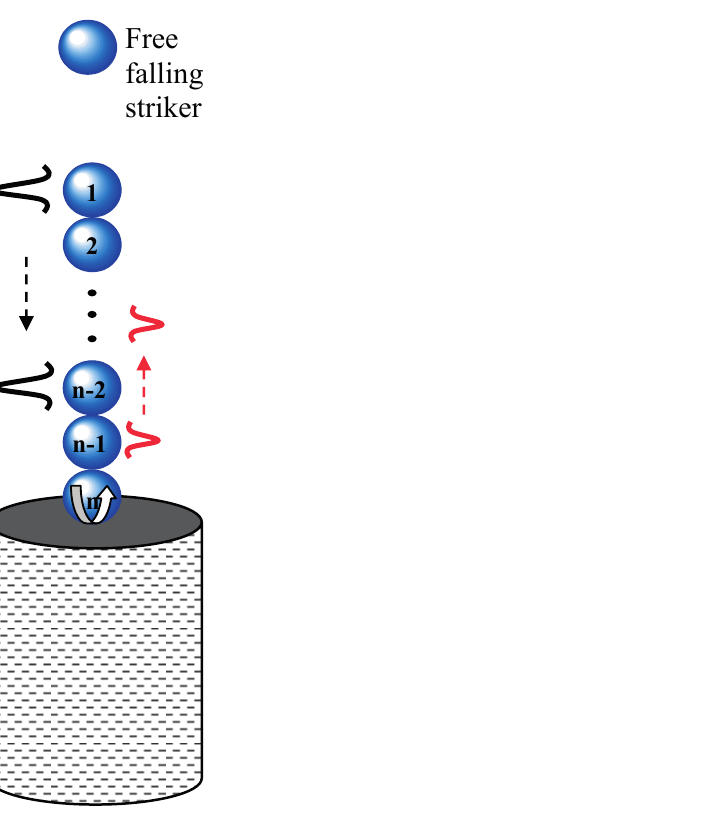
Figure 2. General scheme of structural assessment by means of